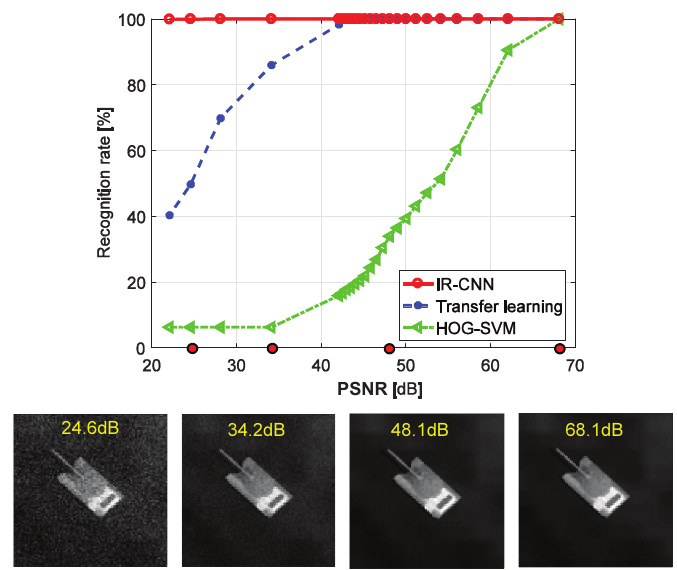
Figure 12. Performance comparison between IR-CNN, transfer learning, and HOG-SVM on the IR